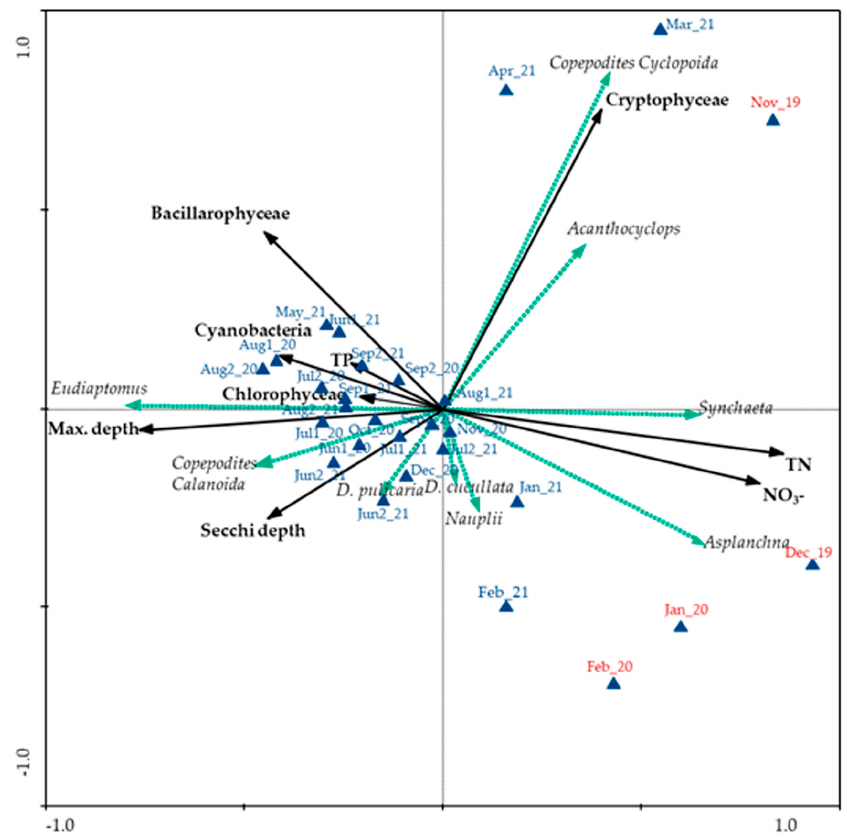
Figure 8. Triplot diagram of zooplankton dominating taxa, explanatory variables and samples in RDA analysis. Blue triangles indicate the samplings and red lettering the samplings during the impoundment period, solid arrows indicate the explanatory variables (phytoplankton groups Bacillarophyceae, Cryptophyceae and Cyanobacteria), maximum depth (Max. depth) and Secchi depth, total organic nitrogen (TN), nitrate nitrogen (NO 3 − ) and total phosphorus (TP), and the green dotted lines indicate zooplankton dominating taxa based on biomass.